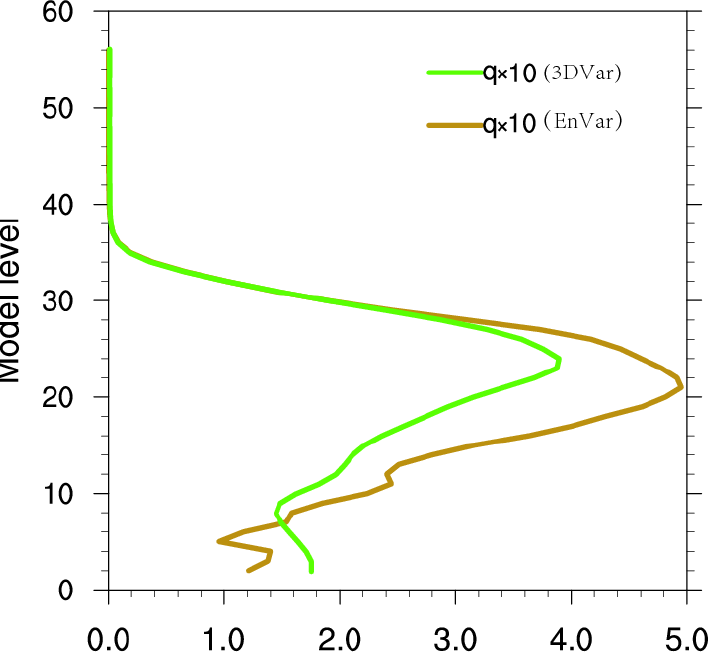
Figure 10. The RMSD profile of the analysis increment of specific humidity (unit: 0.1 g/kg) at 0600 UTC on 21 July 2018.